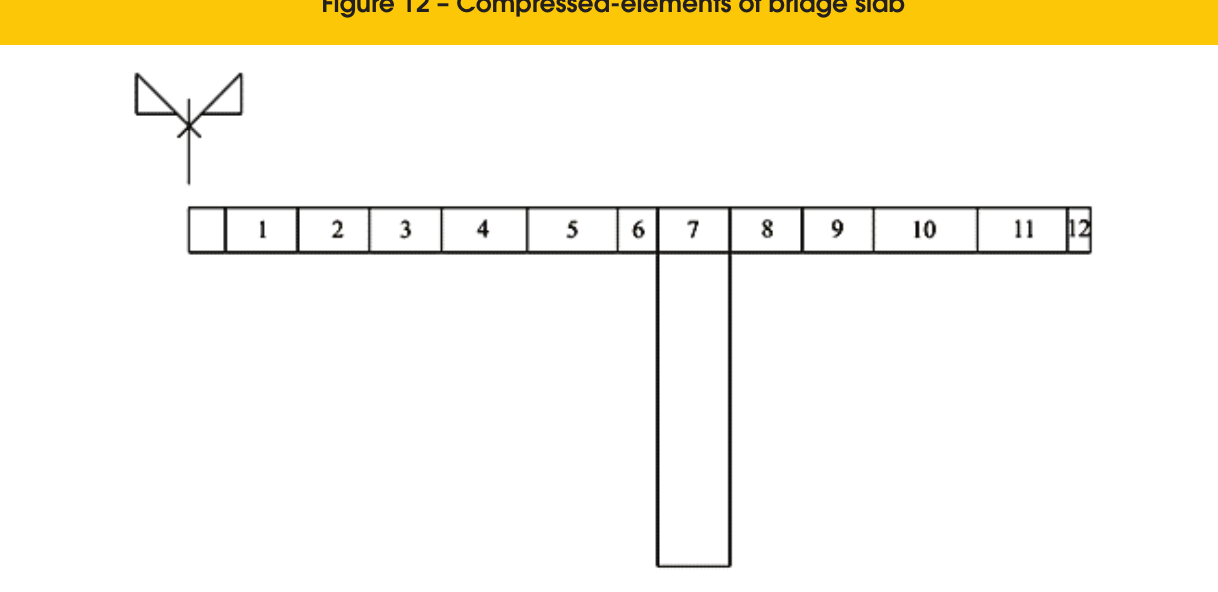
Figure 12 – Compressed-elements of bridge